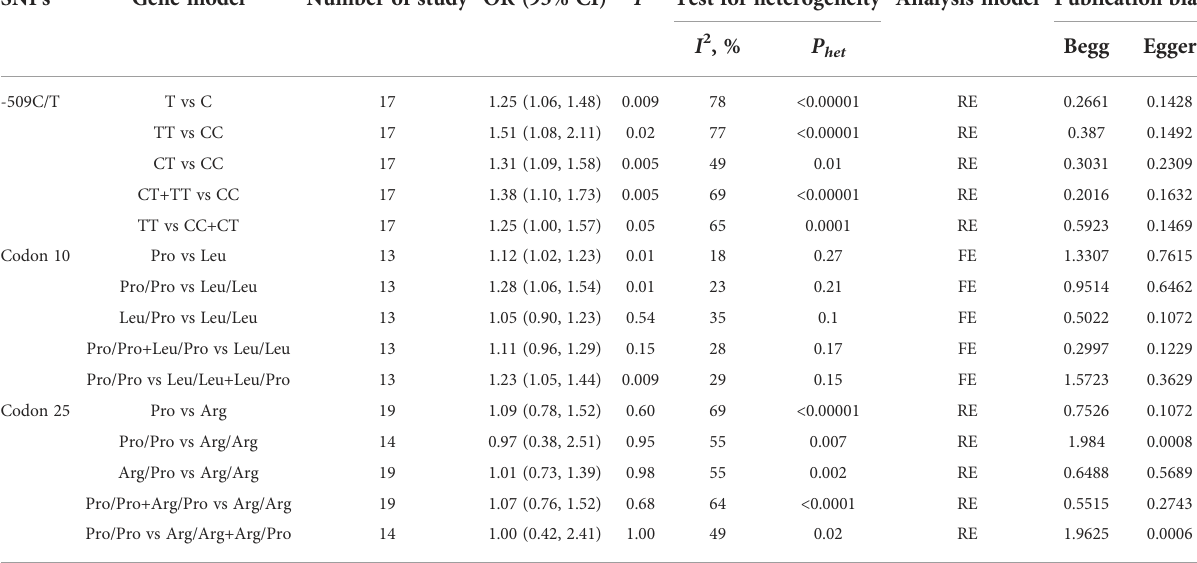
TABLE 5 Main results of the meta-analysis of TGF- b 1 polymorphisms in